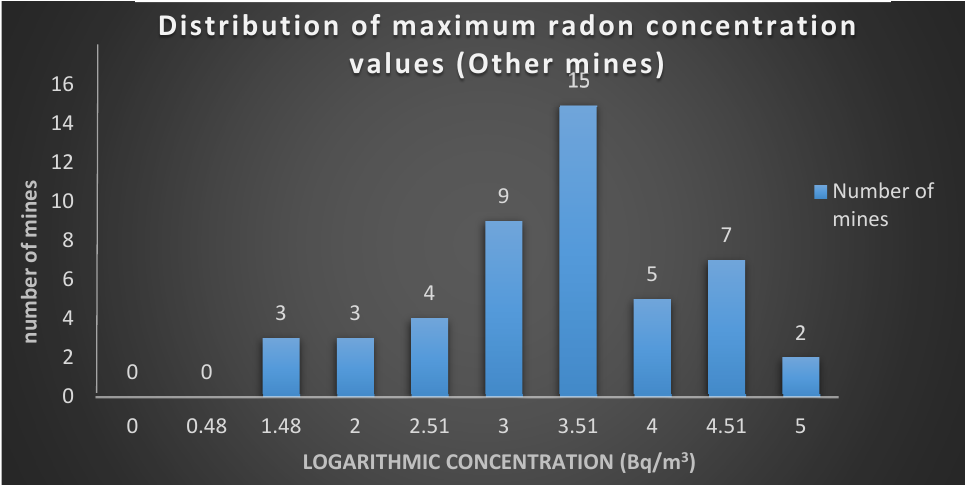
Figure 3. Distribution of radon concentration in other